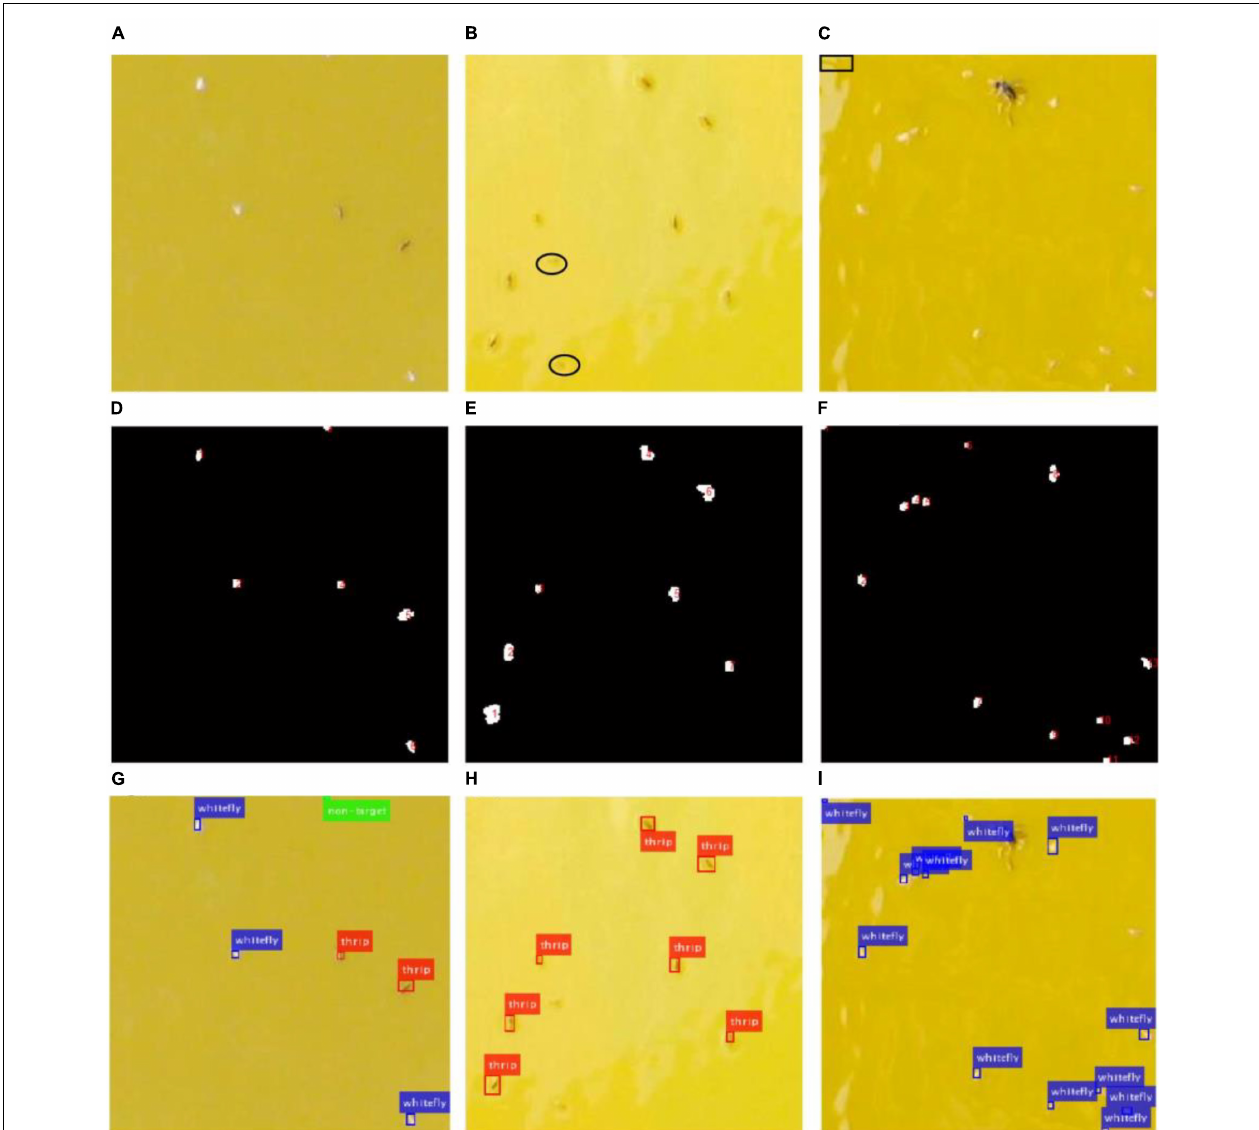
FIGURE 9 | Original images, location results and detection results of three image samples with different quality. (A,D,G) Are for sample 1, (B,E,H) are for sample 2, (C,F,I) are for sample 3.